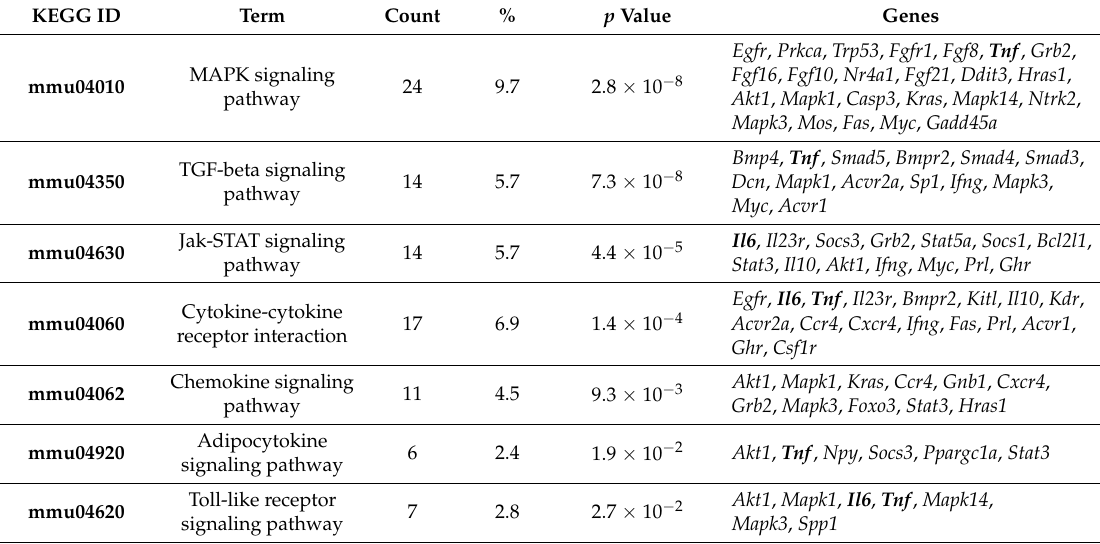
Table 3. Validated target genes enriched by the Kyoto Encyclopedia of Genes and Genomes (KEGG) pathway.